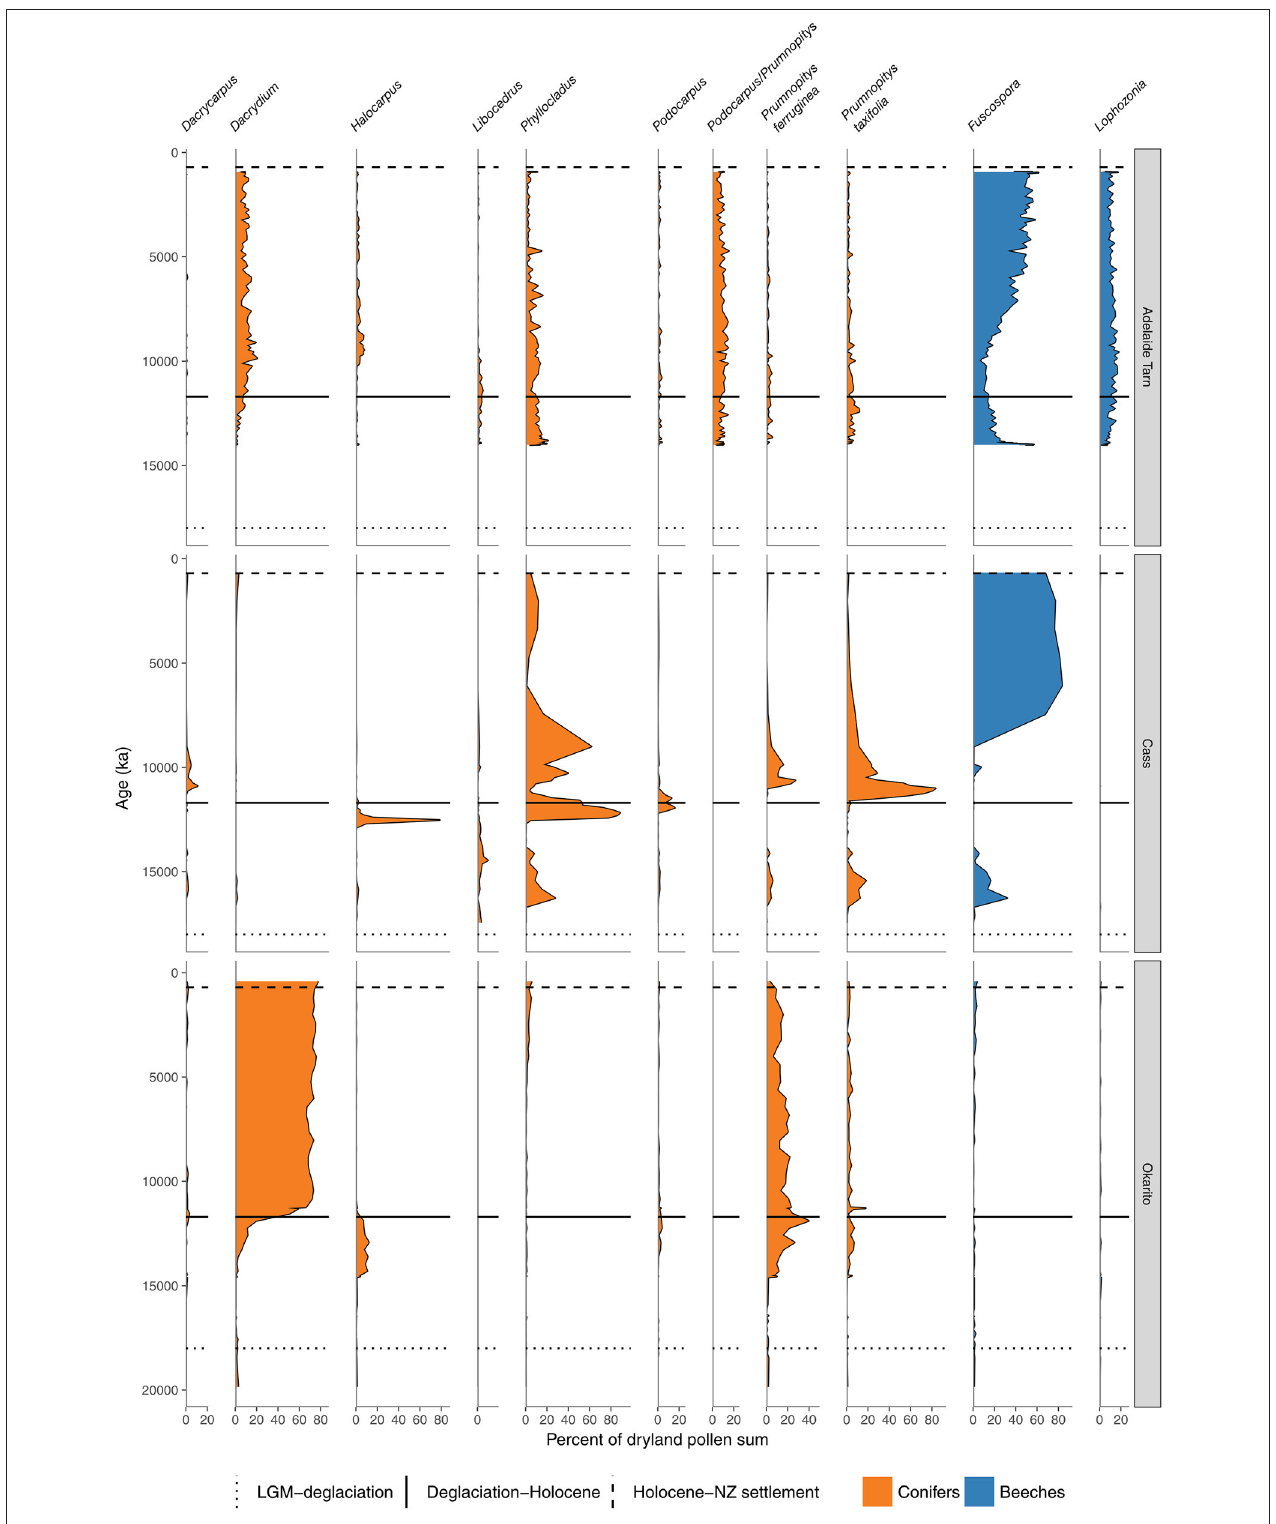
FIGURE 7 | Conifer and Nothofagaceae pollen sequences (cont.). Adelaide Tarn, treeline, Northwest Nelson (Jara et al., 2015). Cass Basin, Kettlehole Tarn, inland Canterbury (McGlone et al., 2004). Okarito bog, central West Coast (Newnham et al., 2007).